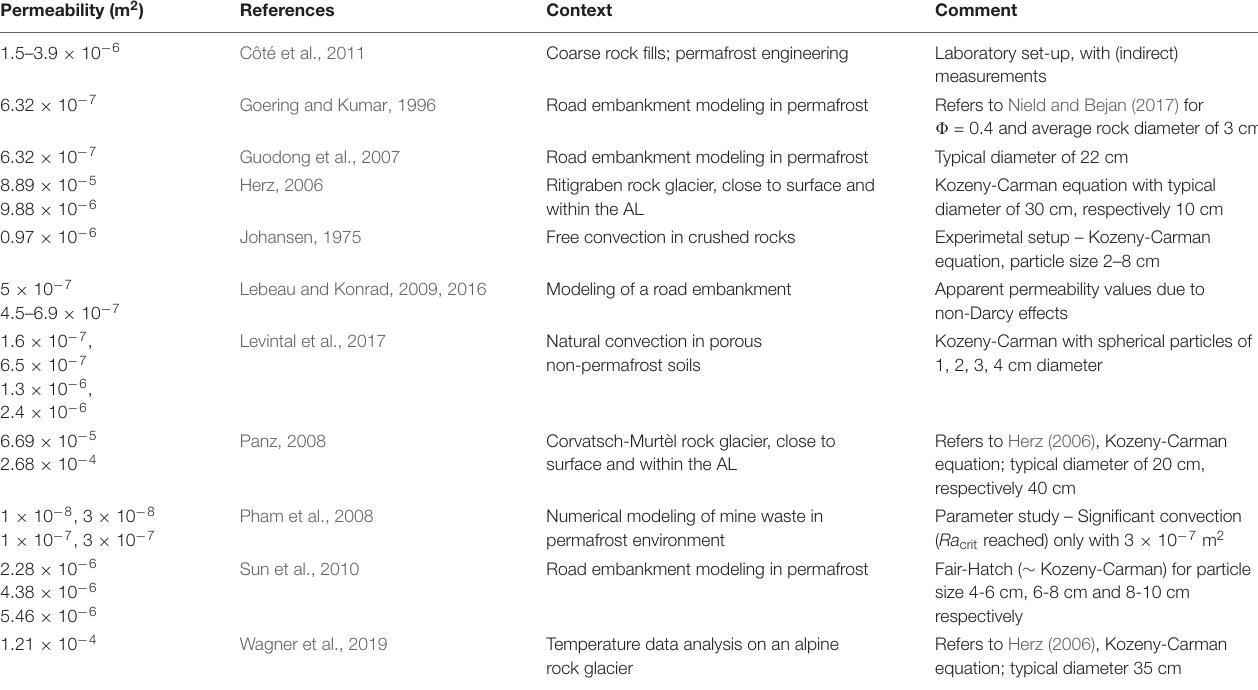
TABLE 4 | Literature values for intrinsic